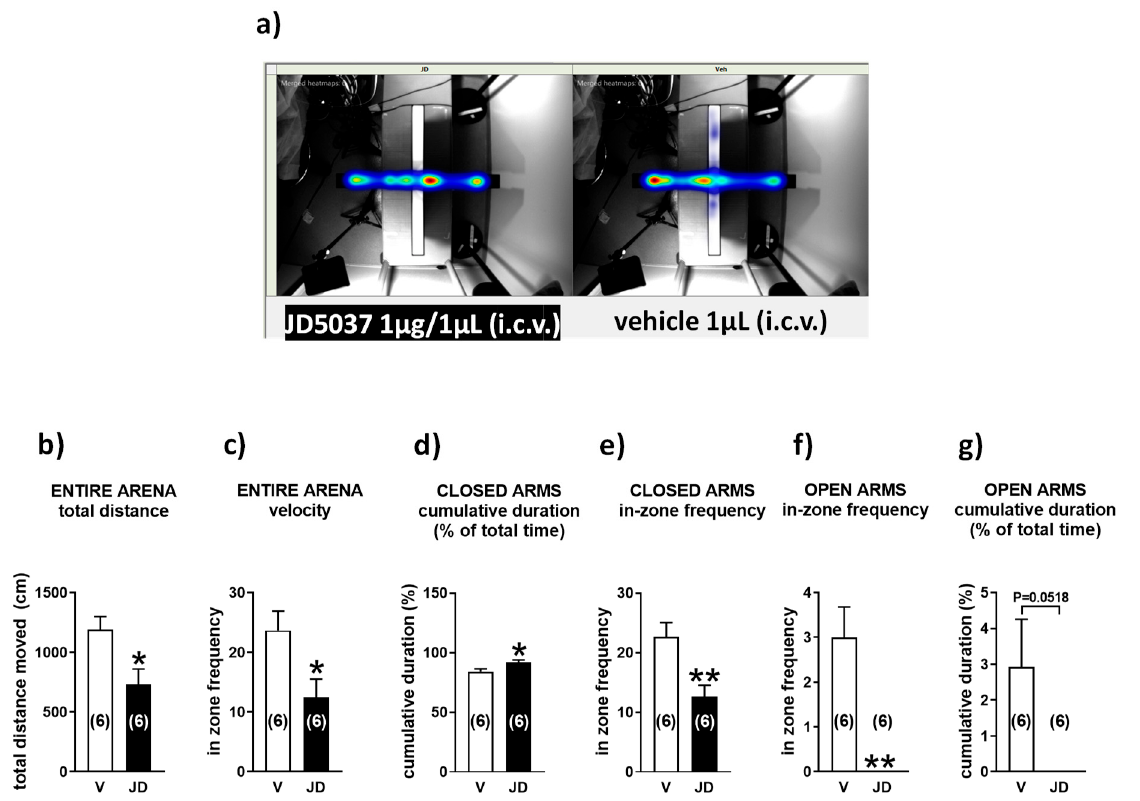
Figure 2. Intracerebroventricular microinfusion of JD5037 increases anxiety-related behavior in the elevated plus maze test. Heat maps ( a ) and summary of mouse activities in individual compartments ( b – g ) of the elevated plus maze. Animals received i.c.v. infusion of JD5037 (1 µg; JD) or its vehicle (3% DMSO, 8% Tween 80, 30% PEG-400, 59% saline; V). They were tested in the elevated plus maze 1 h later. The computerized EthoVision video tracking system was used for data collection and analysis. Bars are mean ± s.e.m. * p < 0.05, ** p < 0.01, compared with vehicle.